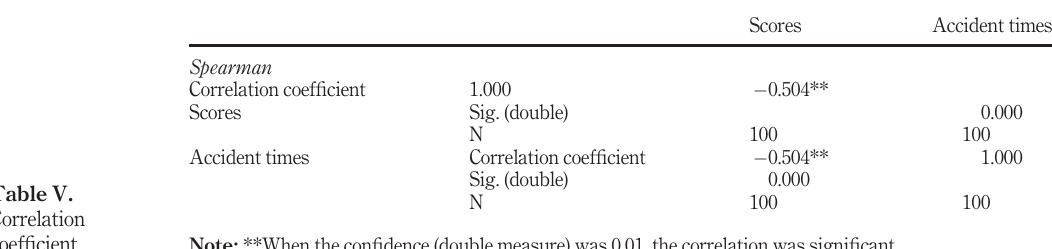
Scores Accident times